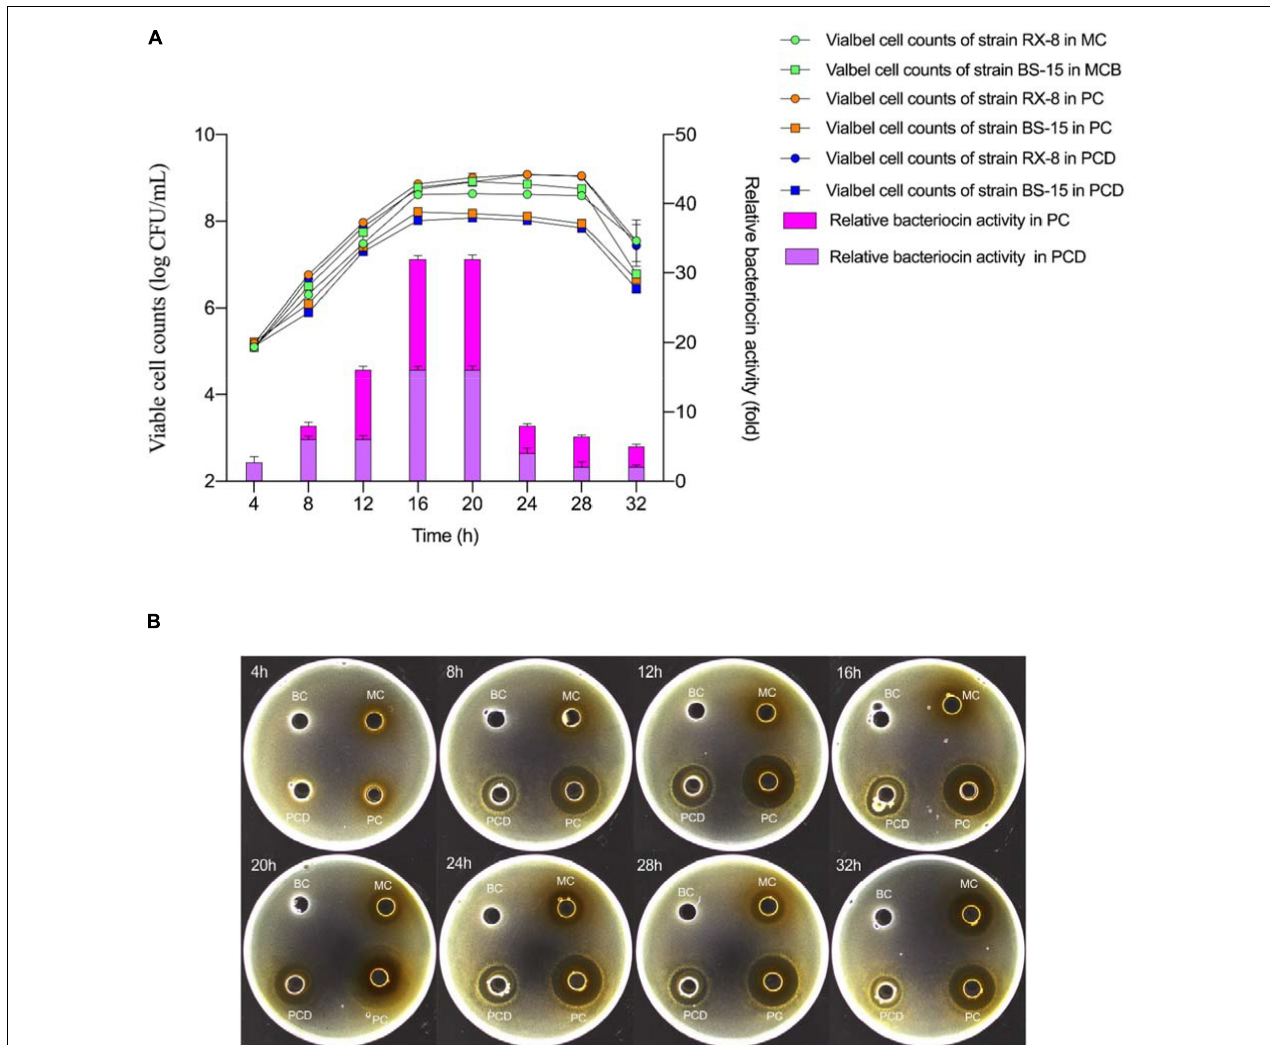
FIGURE 5 | Viable cell amount and plantaricin production in co-culture. (A) Viable counts (left) and relative bacteriocin activity (right). (B) The plantaricin production at every 4 h from 4 to 32 h. PC means positively bacteriocin-inducing co-culture of L. plantarum RX-8 and B. subtilis BS-15 (10 6 :10 6 CFU/ml) at 37 ◦ C in 4–32 h. PCD means PC with 200 mM D-ribose. MC means monoculture of L. plantarum RX-8 (10 6 CFU/ml) at 37 ◦ C in 4–32 h, MCB means monoculture of B. subtilis BS-15 (10 6 CFU/ml) at 37 ◦ C in 4–32 h. BC means blank control (20 mM sodium phosphate buffer, pH 6). The relative bacteriocin activity was defined as the ratio of bacteriocin activity in co-culture to that in